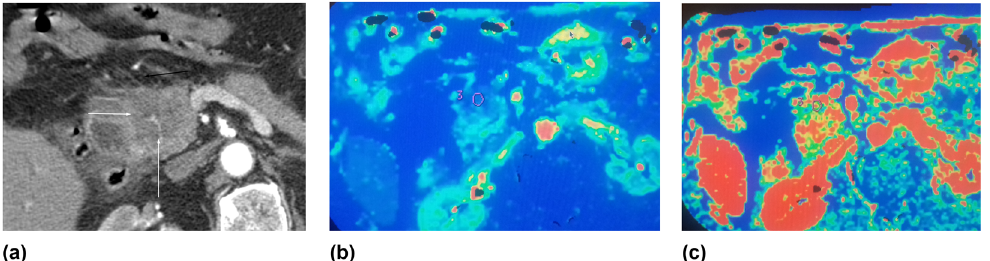
Figure 3: ( a – c ) Moderately di ff erentiated ( G2 ) PDAC in the head of the pancreas. Contrast - enhanced CT images of PDAC ( G2 ) in the head of the pancreas: ( a ) arterial phase – a hypodense tumor in the head of the pancreas ( white arrows ) with in fi ltration of the peripancreatic fatty tissue ( black arrow ) ; ( b – c ) perfusion CT images of the same patient with G2 ( moderate di ff erentiated ) tumor: ( b ) reduced BF in the tumor was detected ( blood fl ow 43.24 mL min − 1 100 g − 1 ) ; ( c ) reduced blood volume of the tumor – 7.6 mL 100 g − 1 ( ROI )